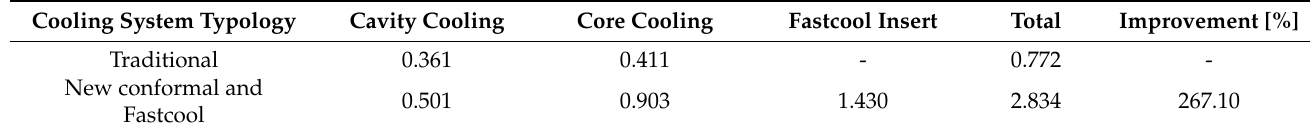
Table 8. Heat flux (J/s · cm 2 ) for the analyzed cooling systems.